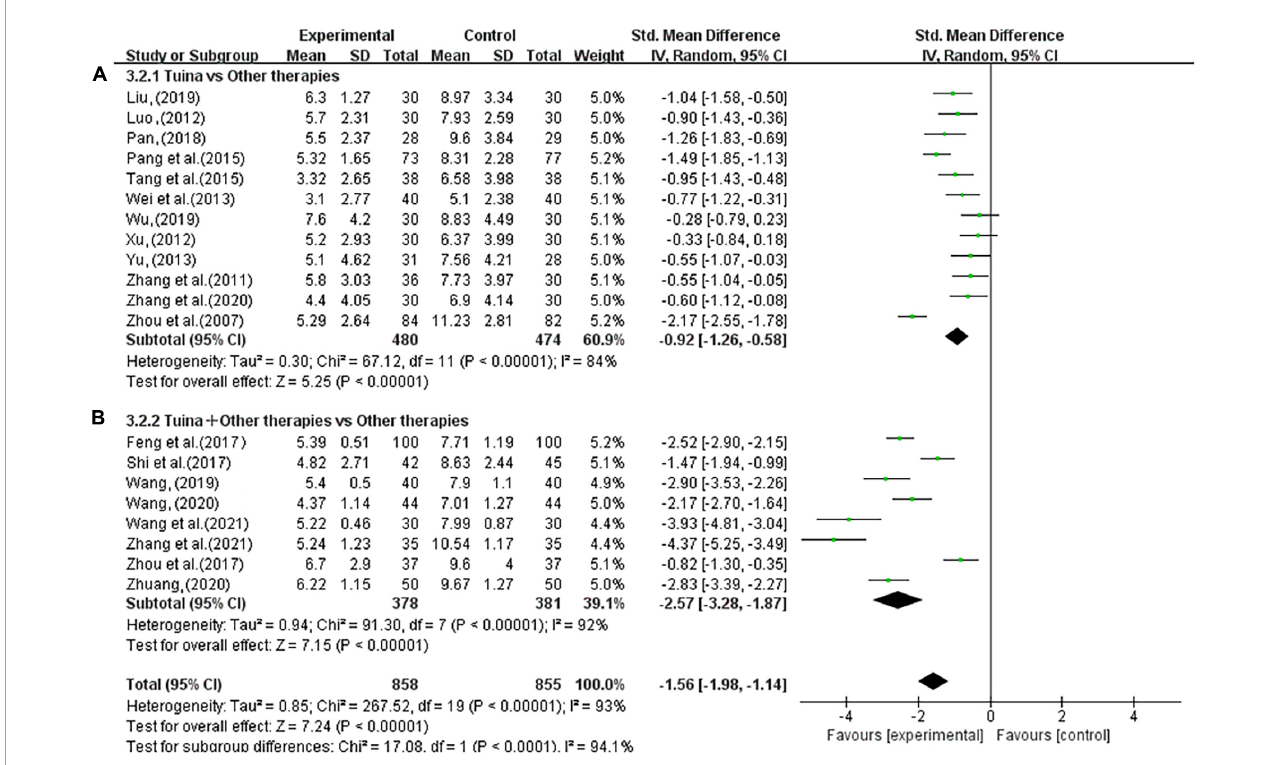
FIGURE8 Forest plot of tuina for Pittsburgh Sleep Quality Index (PSQI). (A) Tuina vs. Other therapies. (B) Tuina + Other therapies vs. Other therapies.